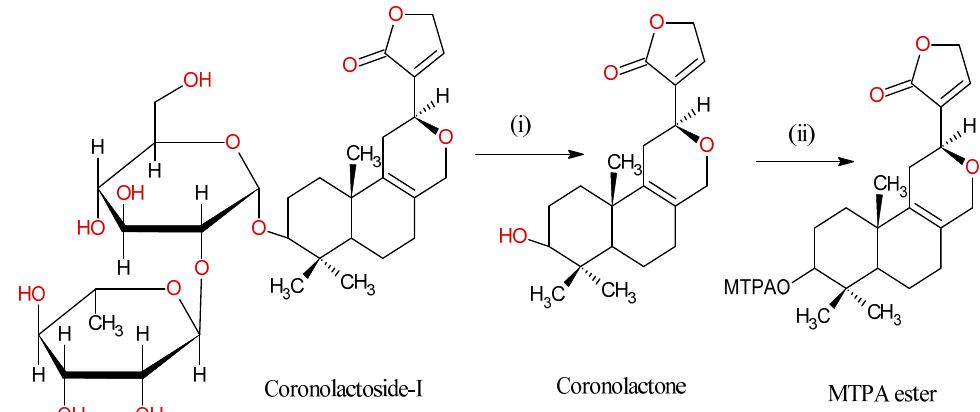
Figure 8. Enzymatic hydrolysis of Coronolactoside-I; (i) Naringinase, 0.2 M acetate buffer, 40 ◦ C, 24 h. (ii) (+) or ( − )-2-Methoxy-2-trifluoromethylphenylacetyl chloride ((+)-MTPACL), Pyridine. Labdane diterpenes Hedychenone was converted to Yunnacoronarin A, Yunnacoro- narin D, Hedychilactone B, 6,7-Dihydrohedychenone, 6,7,11,12-Tetra hydro Hedyche- none, Aldehyde product of Hedychenone, and Dimer of Hedychenone were found to be more cytotoxic than Hedychenone. Coronalactone had an active moiety of Coronalacto- side, and hepatoprotective activity. Table 4. Traditional uses of different parts of Hedychium species